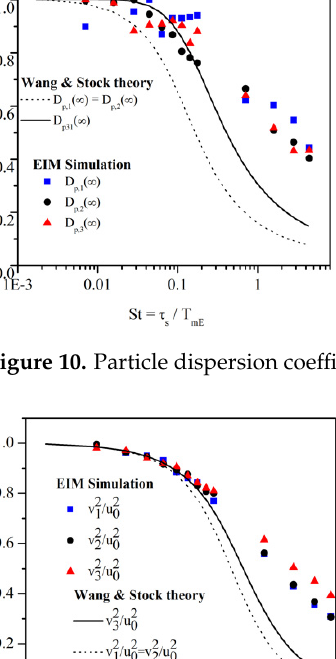
Figure 9. Particle Lagrangian time scale (g ≠ 0).